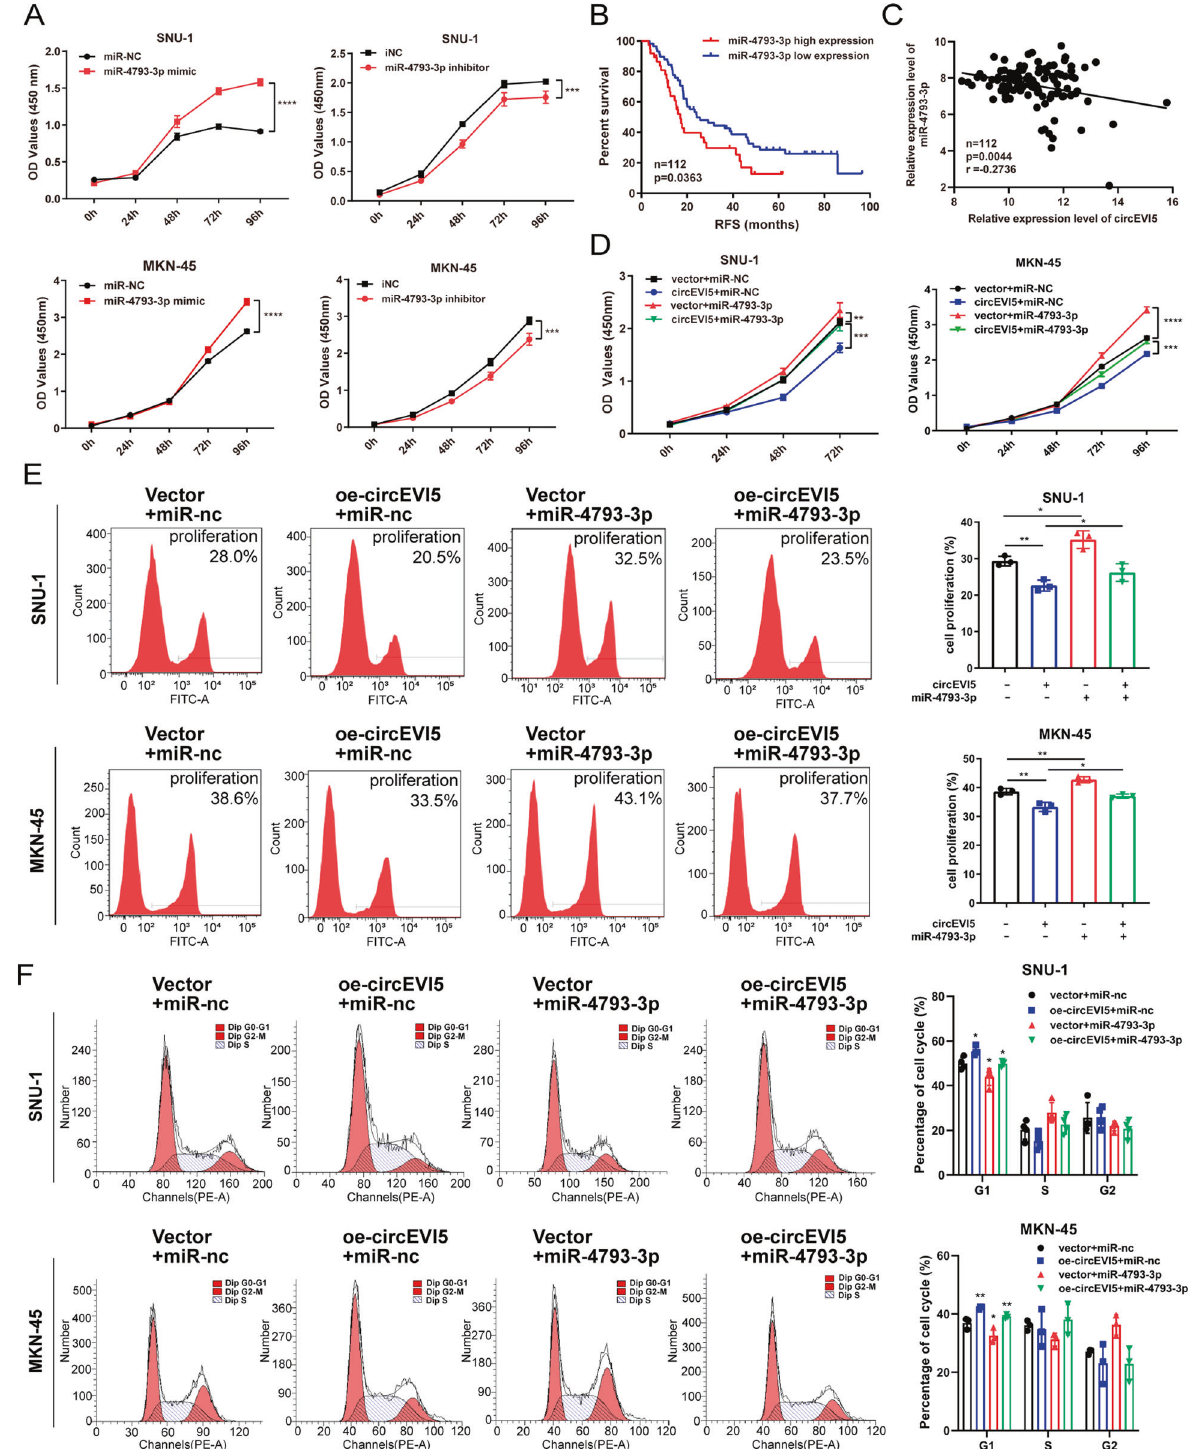
Fig. 4 miR-4793-3p could promote GC cell proliferation and reverse the effects of circEVI5 on GC cells. A The proliferation ability of SNU-1 and MKN-45 cells transfected with miR-4793-3p mimics or inhibitors were detected by the CCK-8 assay. B The RFS curve was drawn using the Kaplan – Meier method ( n = 112). High miR-4793-3p expression showed a poor RFS ( p = 0.0363). C Pearson correlation analysis determined the signi fi cant negative correlation between the levels of circEVI5 and miR-4793-3p in 112 GC tissues ( p < 0.01). D – F . The CCK-8 assay ( D ), EdU incorporation assay ( E ), and PI staining cell cycle assay ( F ) were applied for rescue experiments in SNU-1 and MKN-45 cells to determine whether the biological function of circEVI5 in GC cells could be affected by miR-4793-3p. Rescue experiments were performed with upregulated miR-4793-3p on the basis of circEVI5 overexpression. Overexpression of circEVI5 is represented as oe-circEVI5. Data were shown as the mean ± SD of three independent experiments. * p < 0.05, ** p < 0.01, *** p < 0.001, **** p < 0.0001.